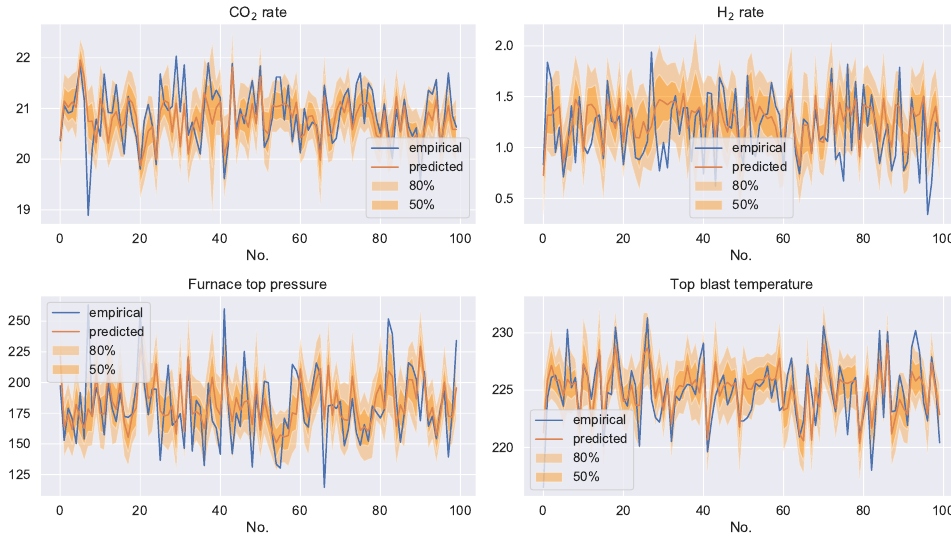
Figure 11. Prediction results of the posterior distribution of uncontrollable variables. The horizontal axis of each subplot indicates the numbers of the samples. The vertical axis indicates the value of each variable.